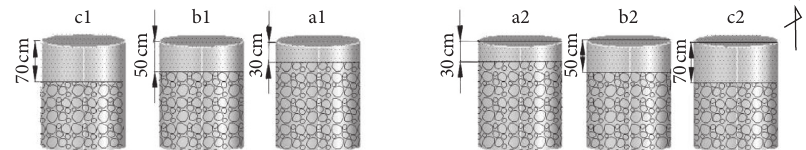
Figure 1: Schematic diagram of 6 test barrels. Note: “a” represents the covering soil with a thickness of 30cm, “b” represents the covering soil with a thickness of 50cm, “c” represents the covering soil with a thickness of 70cm, “1” represents that the topsoil is not compacted, “2” represents that the topsoil is one time compacted, and “a1” represents that the soil with a thickness of 30 cm is not compacted. The meaning of the subsequent test barrel number is the